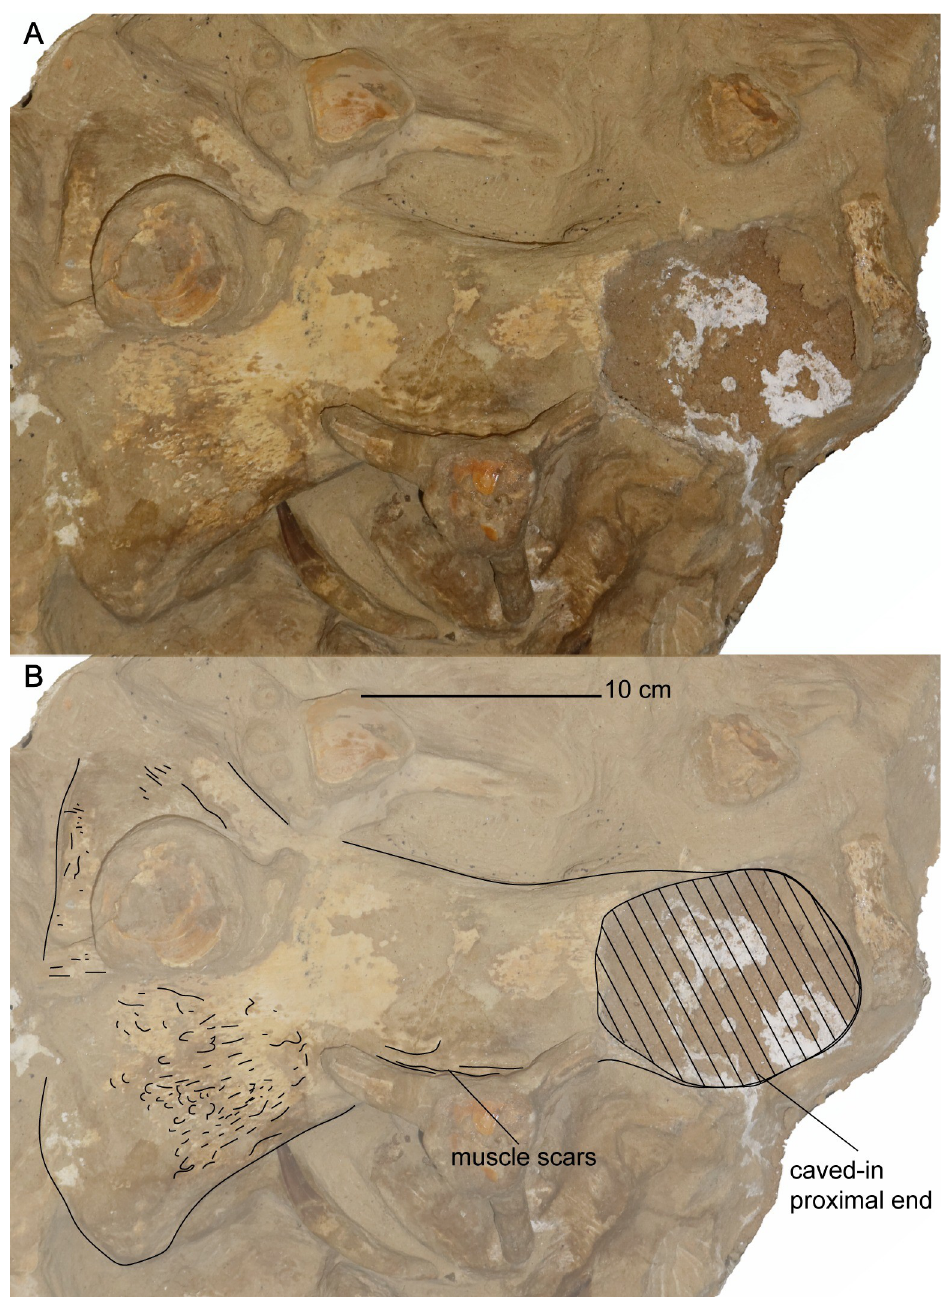
Fig 23. Femur of Cardiocorax mukulu (MGUAN PA278) in dorsal view. than the shaft and is covered along the dorsal surface by rugose, sub-parallel ridges. The ridges become smooth and flatten toward the diaphysis. The femur of MGUAN PA278 does not pres- ent a posterodistal expansion as in AMNH 1495 ( Styxosaurus sp.) [7], Terminonatator ponteixen- sis [40], Vegasaurus molyi [93], and Aphrosaurus furlongi [3]. Rather, the anterodistal and posterodistal margins of the femur in MGUAN PA278 are more evenly expanded, as in Futaba- saurus suzukii [78], Callawayasaurus colombiensis [10], and Jucha squalea [12].